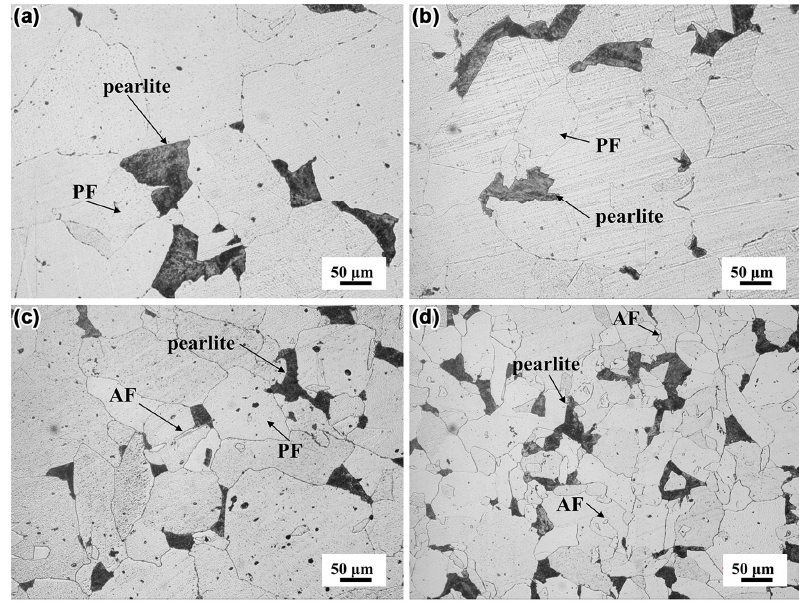
Figure 2. The microstructure of cast ingots, ( a ) N1, ( b ) N2, ( c ) N3, and ( d ) N4 steel.